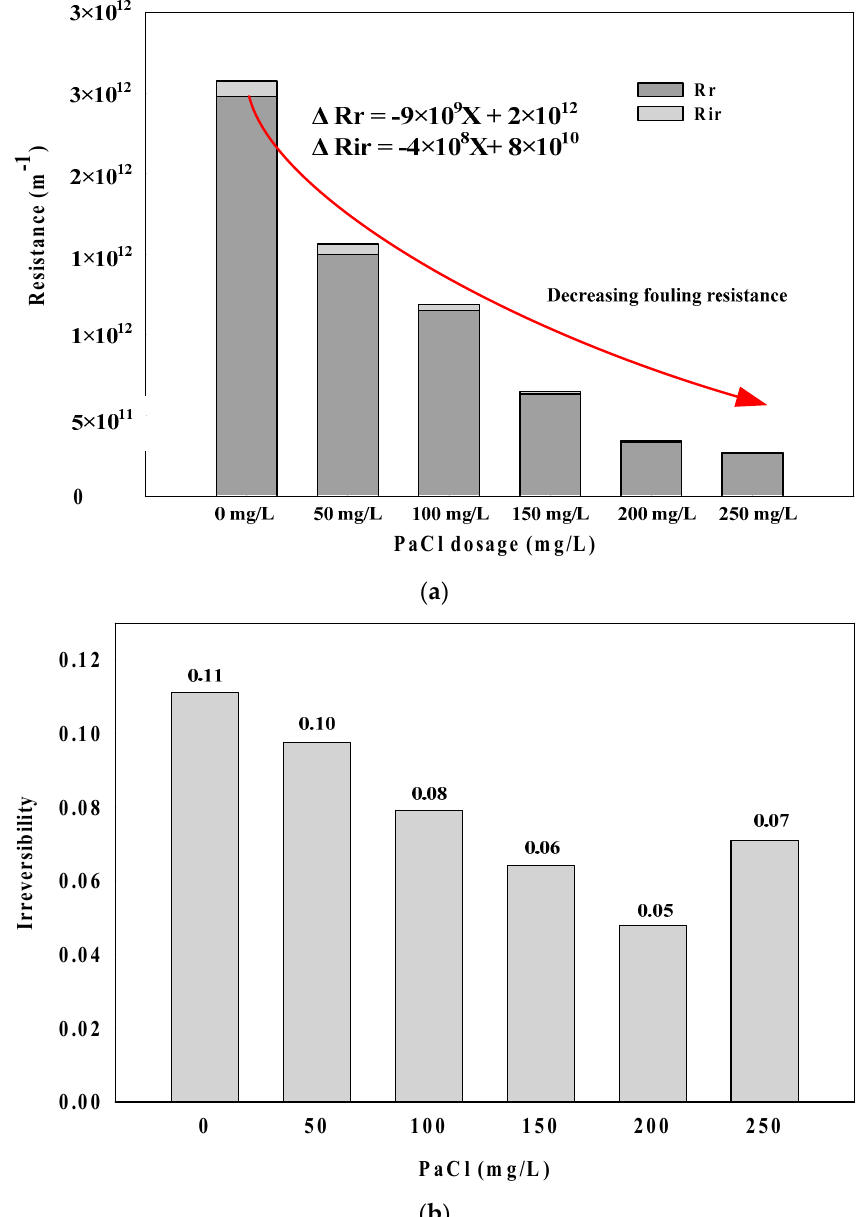
Figure 2. Results of reversible and irreversible analyses according to coagulant dosage. ( a ) R r and R ir filtration resistance with coagulant dosage rate; and, ( b ) Irreversibility analysis with coagulant dosage rate.